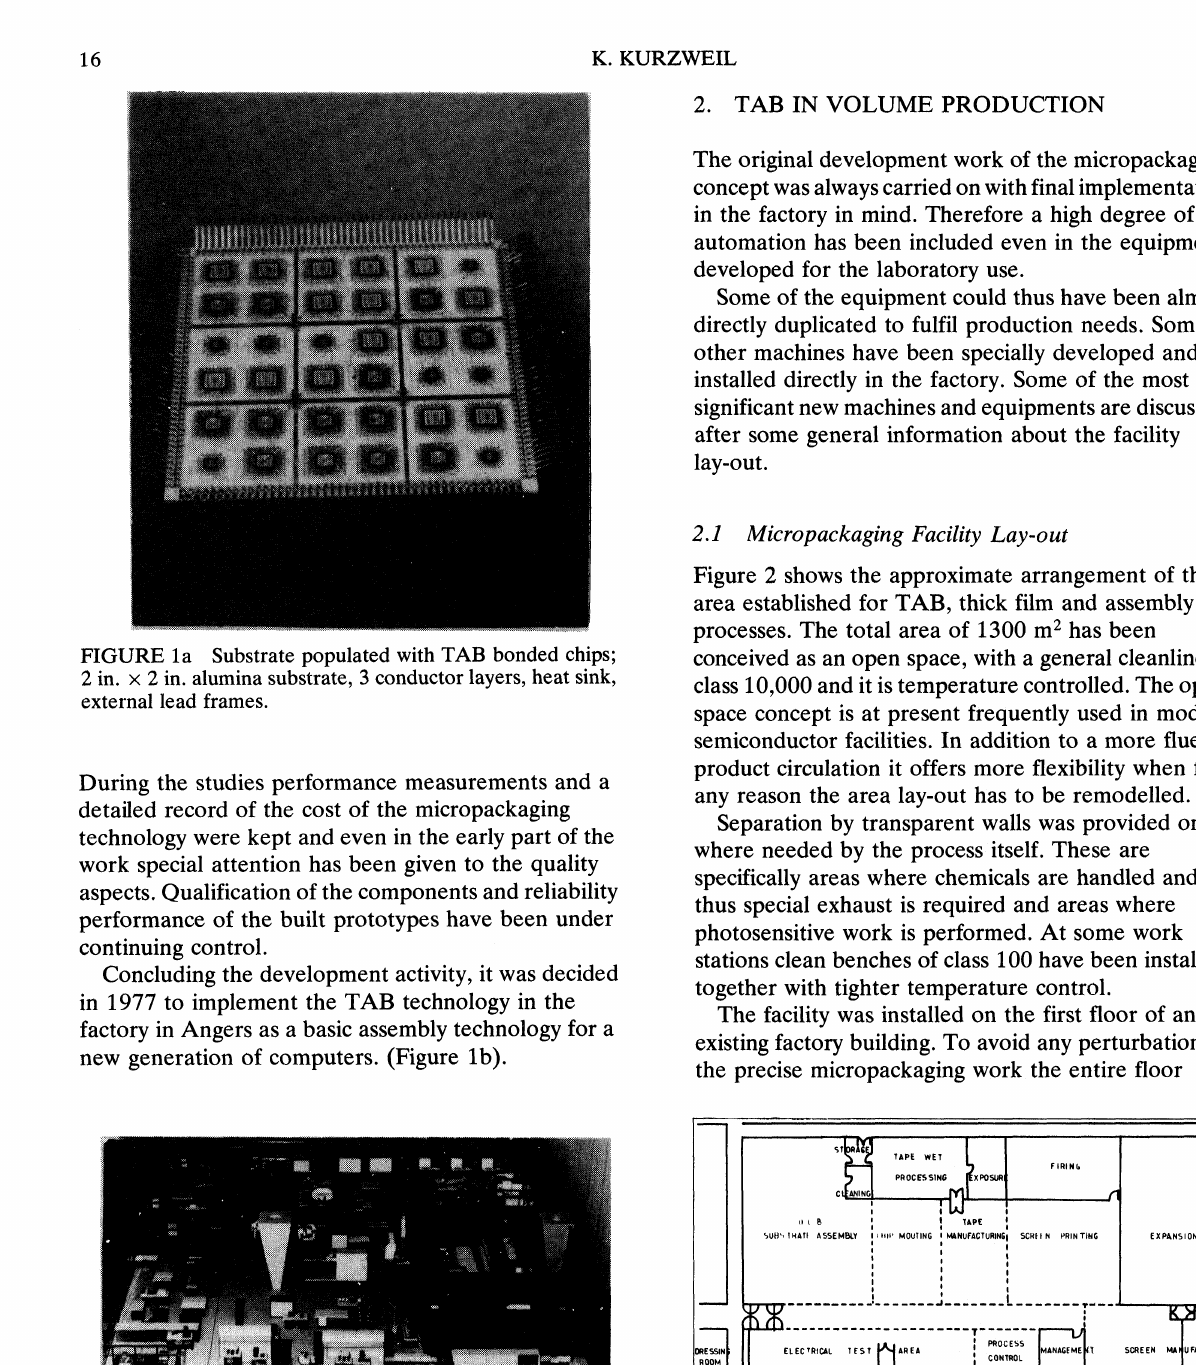
FIGURE 2 Lay-out of the micropackaging manufacturing facility. Total area is 1300 m 2. Solid lines represent glass walls, dashed lines represent theoretical boundaries between communicating